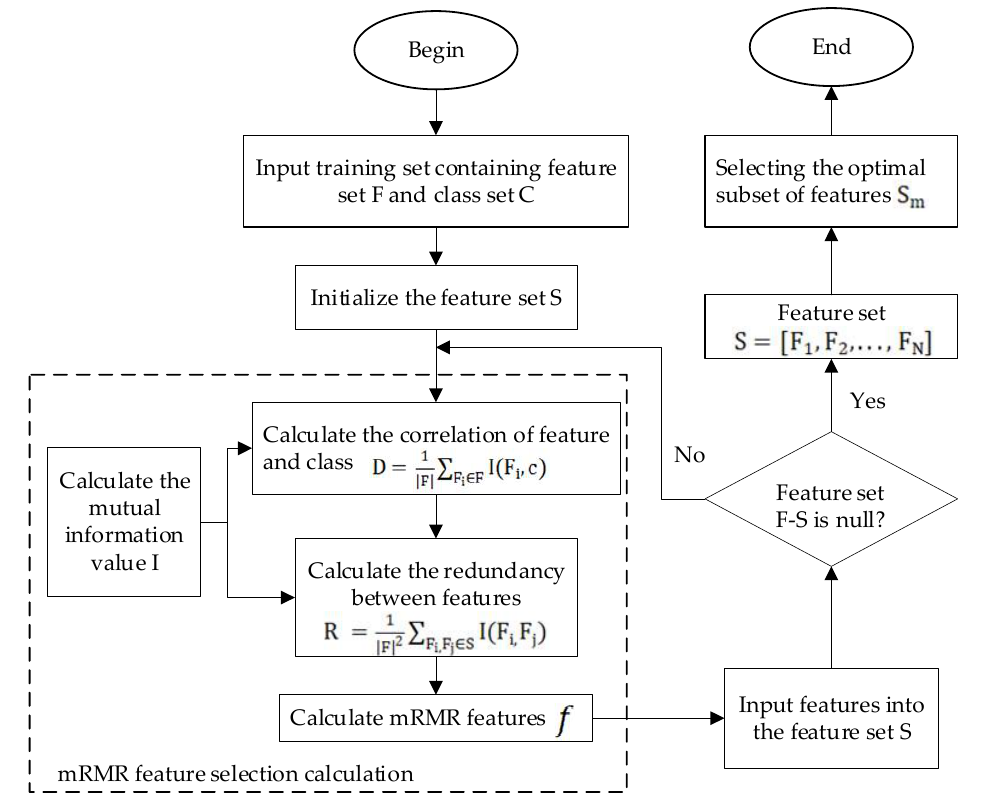
Figure 2. Framework of the mRMR feature selection method.